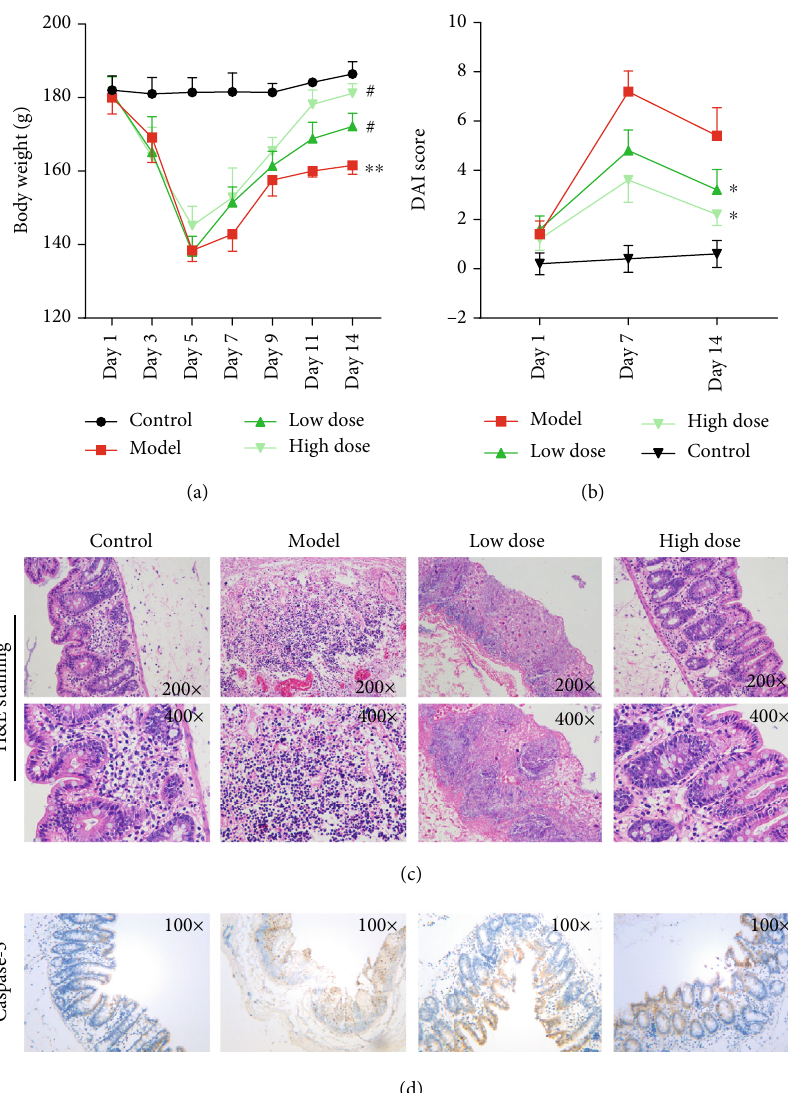
Figure 2: Xi Lei San relieved DSS-induced colitis in rats. (a) A DSS-induced rat model of colitis was constructed, and the model rats were treated with low or high doses of Xi Lei San. The body weights of the rats in each group were measured. (b) After treatment with Xi Lei San, a DAI score was calculated for each group of rats. (c) The pathological examination for rat intestinal tissues was observed after H&E staining. (d) Caspase-3 expression was detected by using immunohistochemistry. ∗ P < 0 : 05 and ∗∗ P < 0 : 01 vs. the control group; # P < 0 : 05 vs. the model